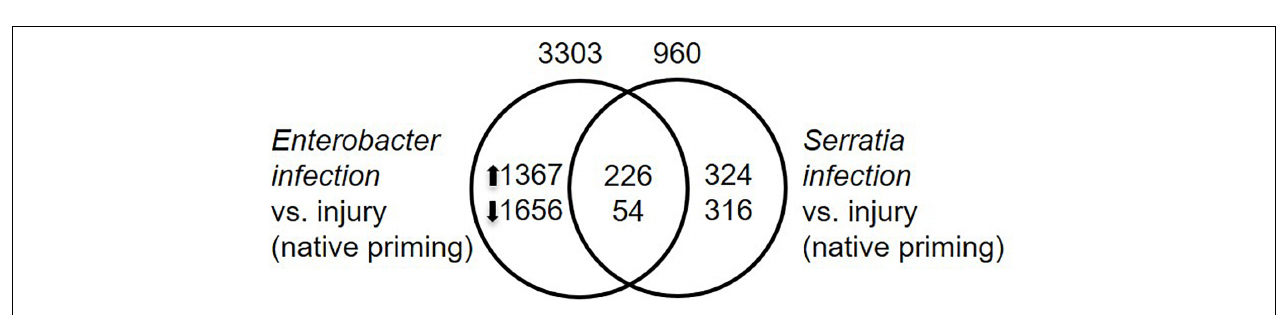
FIGURE 6 | Infection responsive genes. Infection responsive genes were identified by comparison between respective infection vs. injury control with q -value < 0.05 as cutoff. Total number of transcriptionally altered genes was specified on top of the circle, number of up- or down-regulated genes were specified inside the circle.